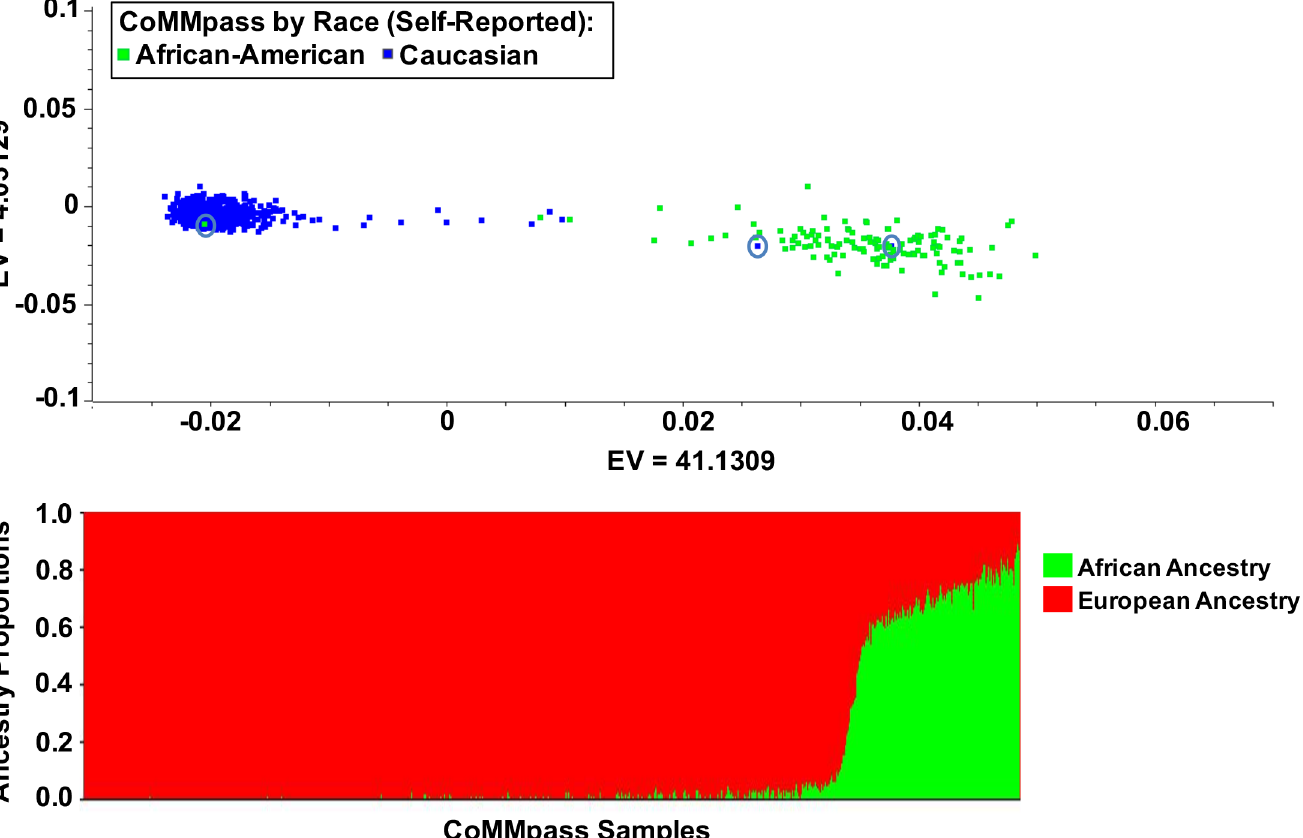
Fig 1. Population stratification by principal component analysis and STRUCTURE plot defining propositions of calculated genetic ancestry. (A) Principalcomponentplot across all samplesby self-reportedrace with Caucasian (blue dots) and African American(green dots) using AIMs derived from the whole-exome deep sequencing. The red circles indicate samplesthat have beenremoved from the analysisdue to misclustering. PCA is calculatedusing SNP & VariationSuite v8.4.1 (GoldenHelix, Inc.) PCA tool by eigenvalue (EV) implementation technique(Methadology). These samples were identifiedas the self-reportedrace. (B) STRUCTURE plot (K = 2; 50,000 Burnin periodand 100,000MCMC repeats) used to interfere genetic clusters and percent admixture: EuropeanAncestry (red), African Ancestry